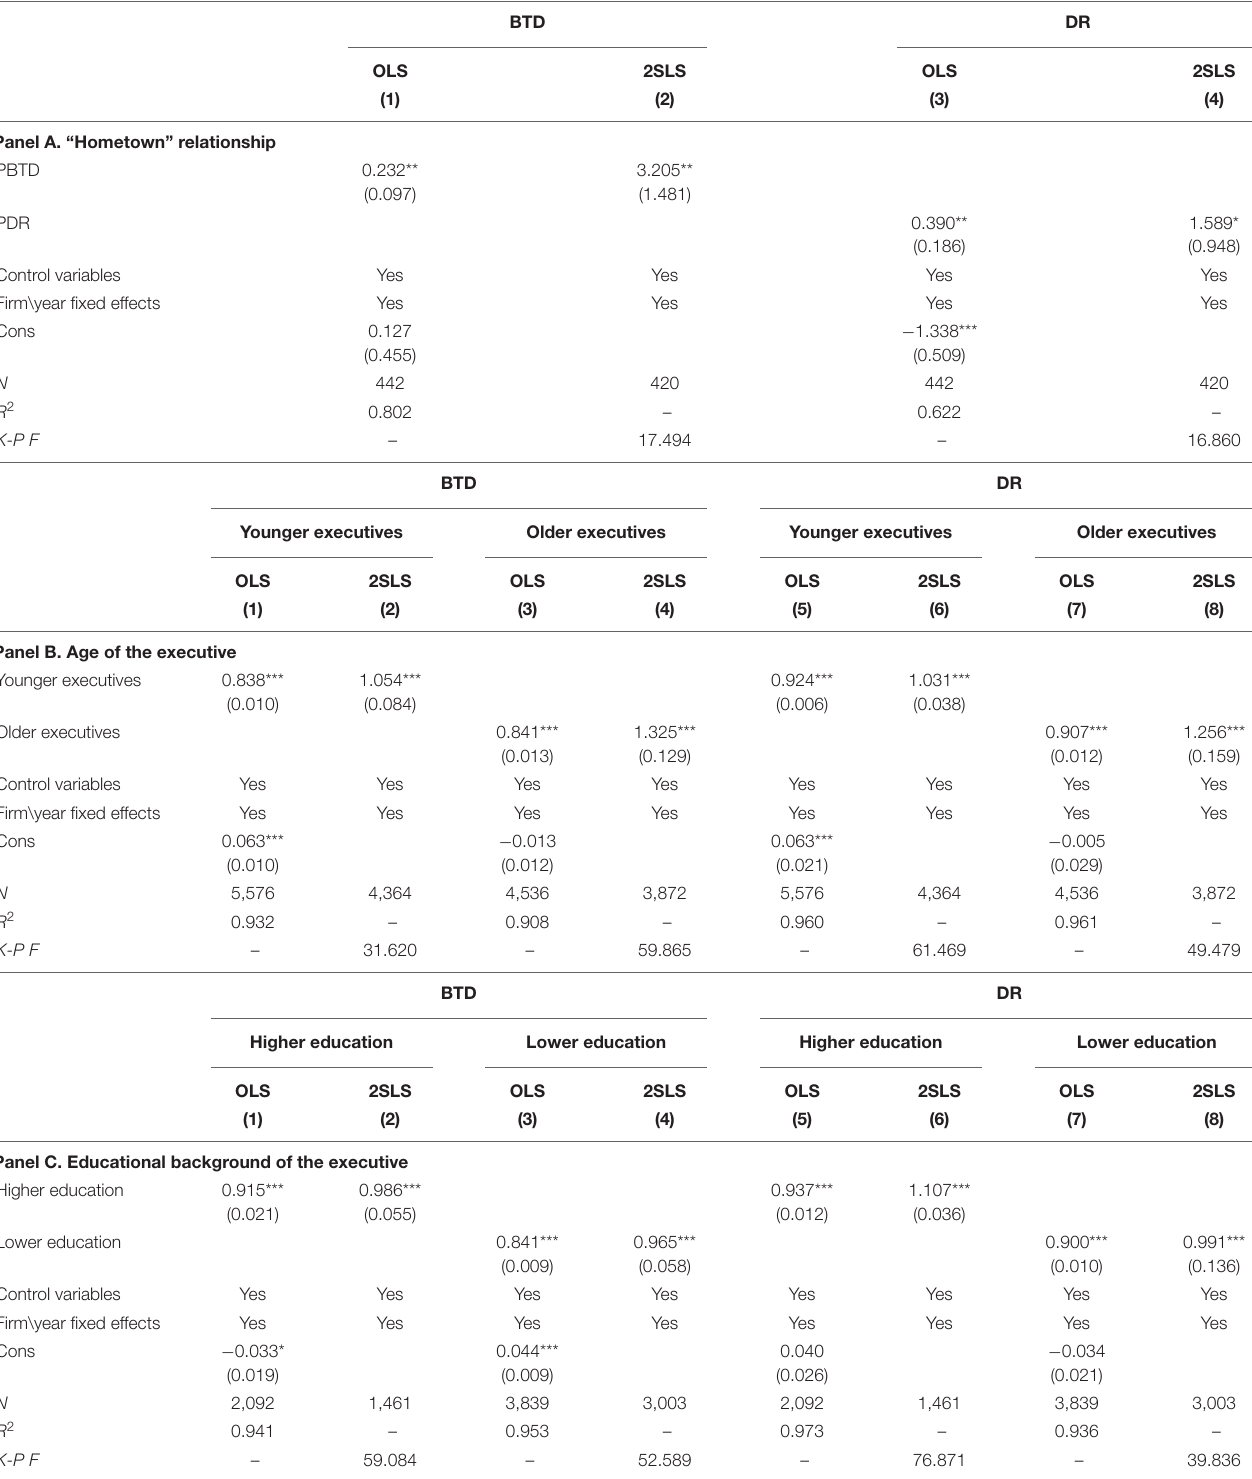
TABLE 5 | Managers’ information